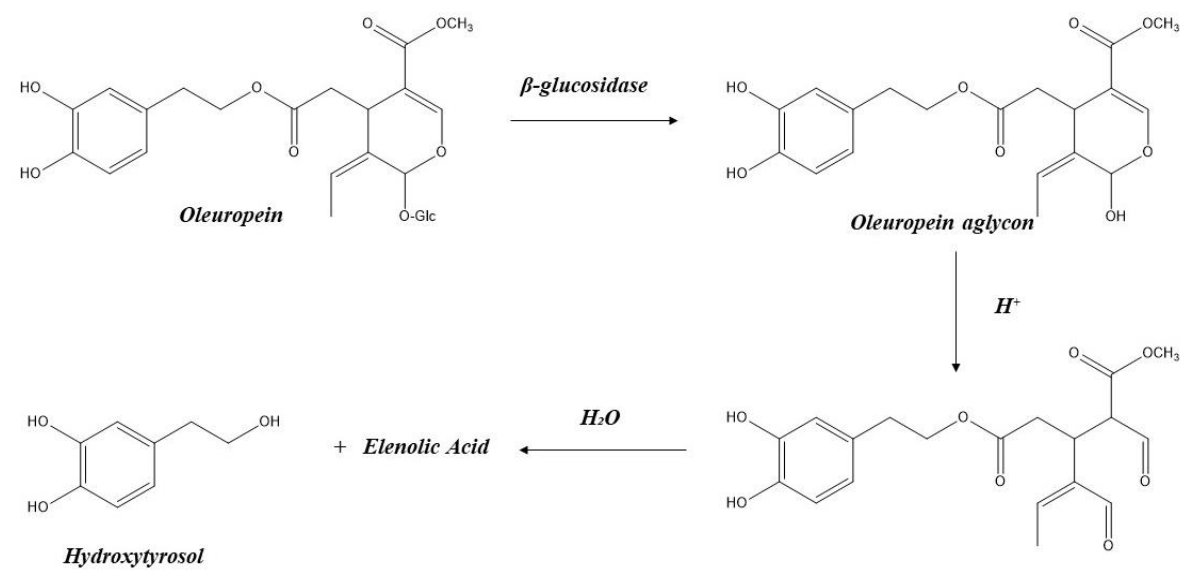
Figure 2. Hydroxytyrosol formation pathway from oleuropein in olive oil.